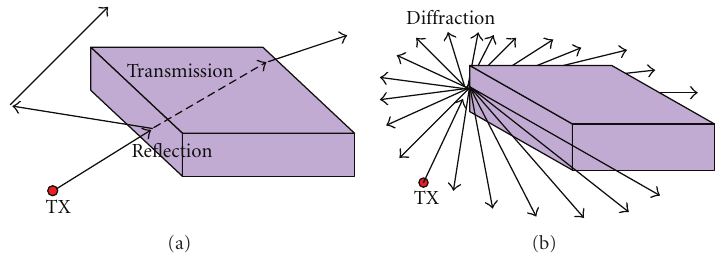
Figure 5: Principle of ray launching method: reflection, transmission, and di ff raction.